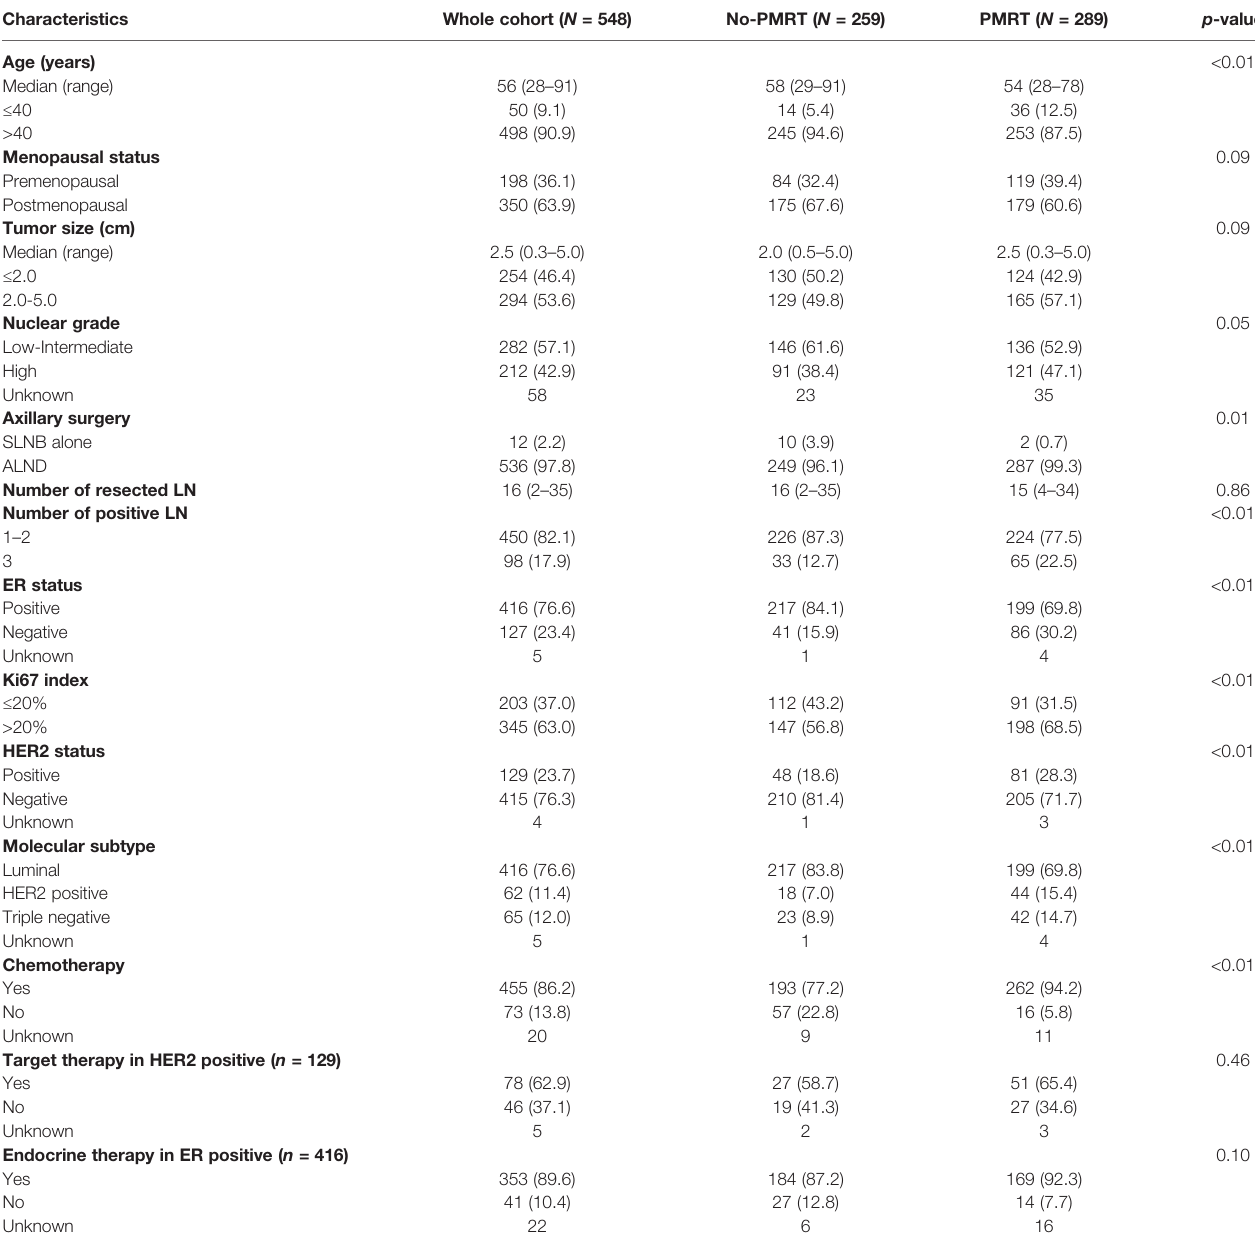
TABLE 1 | Patient and treatment characteristics.